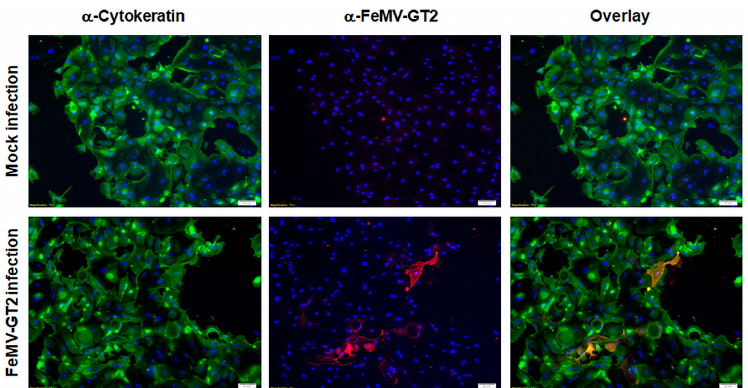
Figure 5. Susceptibility of feline bladder epithelial cells to FeMV-GT2. Primary feline urinary bladder cells were inoculated with FeMV-GT2-Gordon strain (MOI = 0.5) or mock-infected, fixed five days p.i. and stained for cytokeratin (shown in green) or FeMV-GT2 (shown in red). Double positive cells are depicted in orange. Cell nuclei were visualized with DAPI (shown in blue). Images were taken at 100-fold magnification. Scale bars represent 50 µ m.